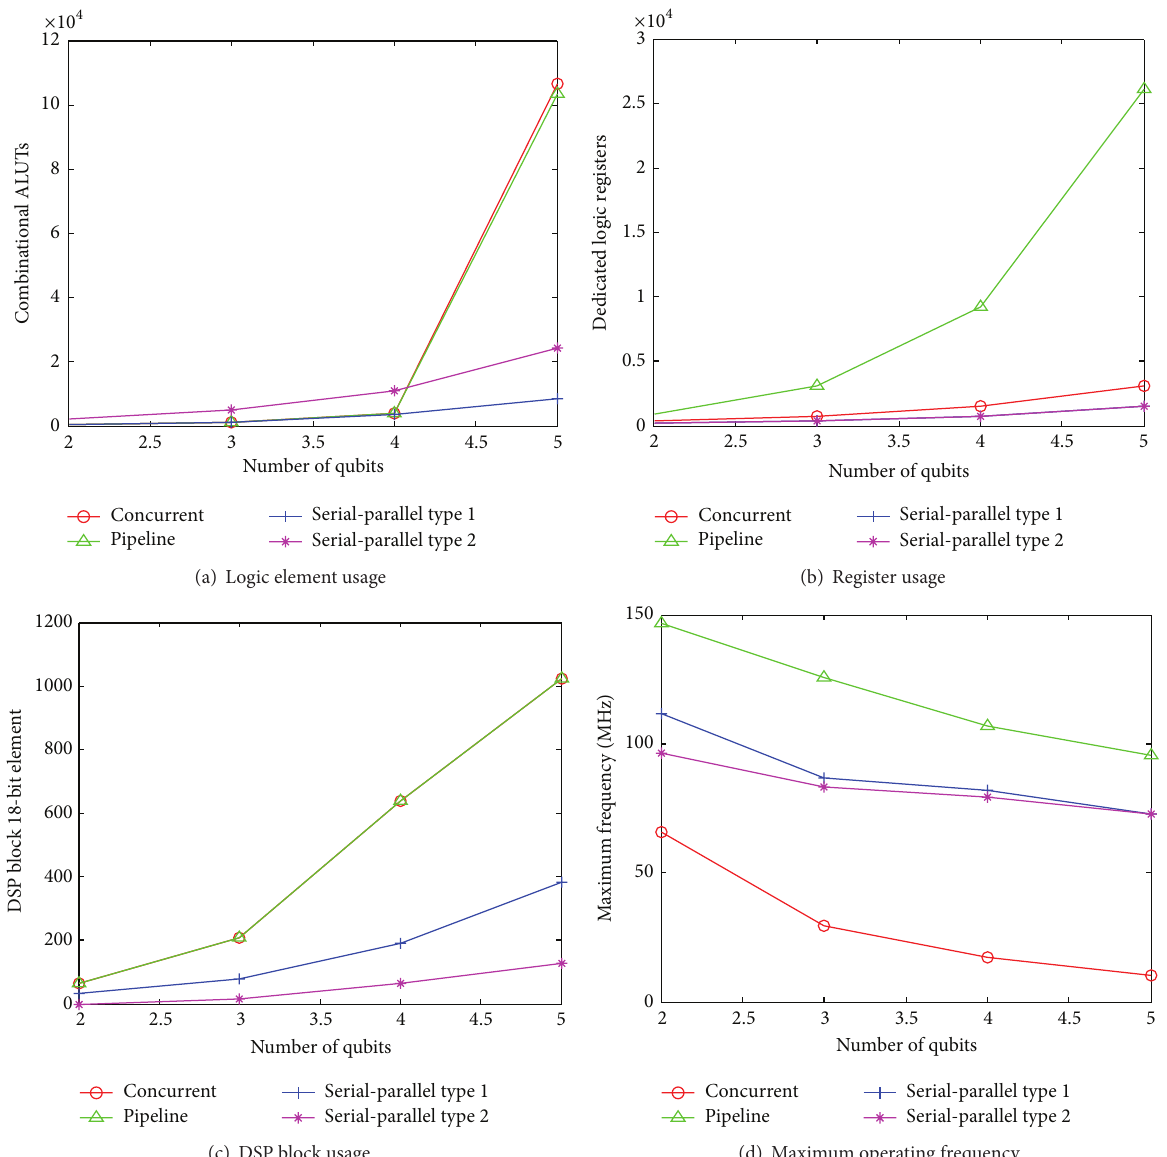
Figure 18: Resource utilization and maximum operating frequency for different emulation architectures of QFT (based on 24-bit fixed point